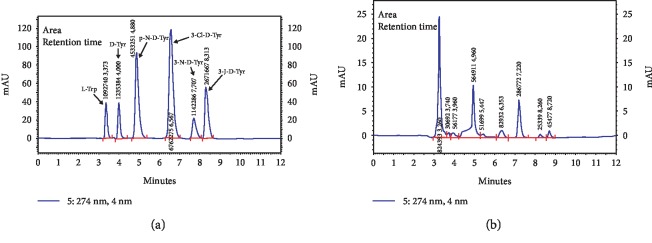
Sample chromatogram (HPLC) for tyrosine and its derivatives: (a) calibration curve and (b) examined sample.